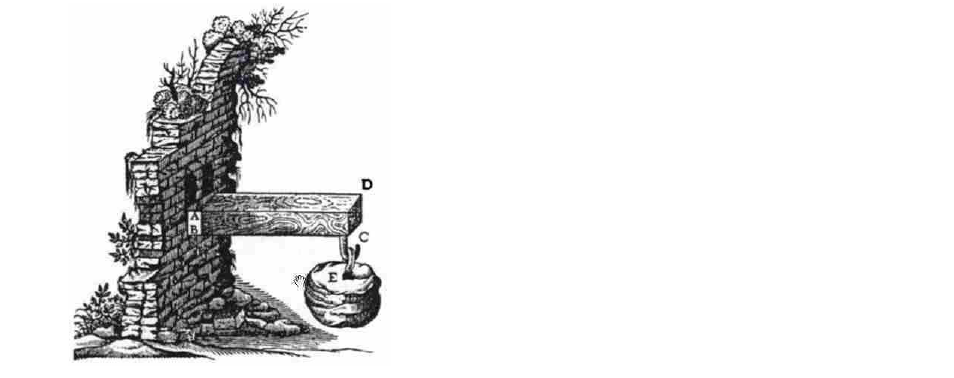
Figure 5. Bridge finite element models (Source: http://www.civil.bim.upct.es/cursos/m5-puentes- bim/, accessed on 29 July 2019). With the implementation of the BIM methodology, already mandatory in Great Brit- ain, Scandinavia, the USA, and Australia among others, 3D digital models are widely used and not only for structural analysis. To explain what the BIM methodology is, we will cite a report by AENOR [21]: BIM is a collaborative work methodology for the management of a project by means of a 3D digital model. It includes methodologies, processes, software and digital formats for the management of projects and construction works. It fo- cuses on buildings, but also applies to civil works (p. 4). It could be defined as a digital representation of the physical and functional characteristics of a building, allowing information to be exchanged to make de- cisions throughout its life cycle (project, construction, use and deconstruction). It can be used to store data, perform calculations or manage the building. [...]